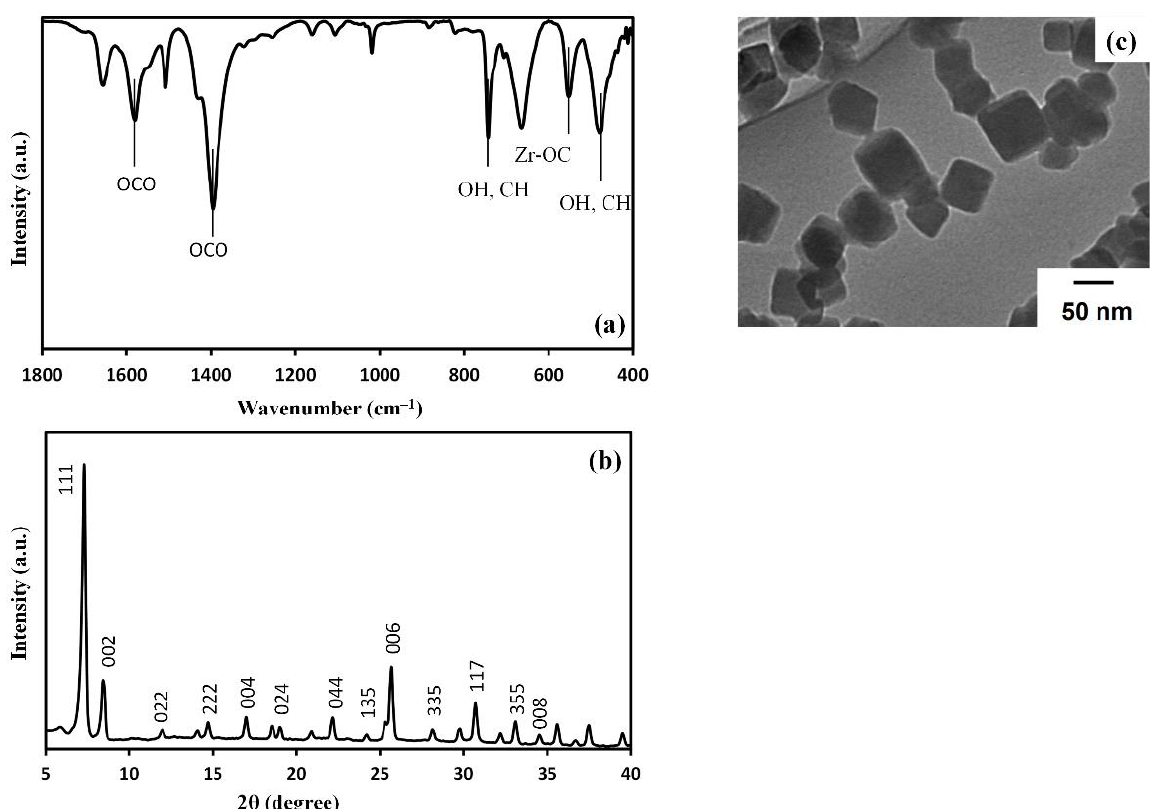
Figure 2. Characterization of UiO-66 nanoparticles: ( a ) FT-IR spectrum, ( b ) XRD diffractogram, and ( c ) TEM image of UiO-66 nanoparticles.